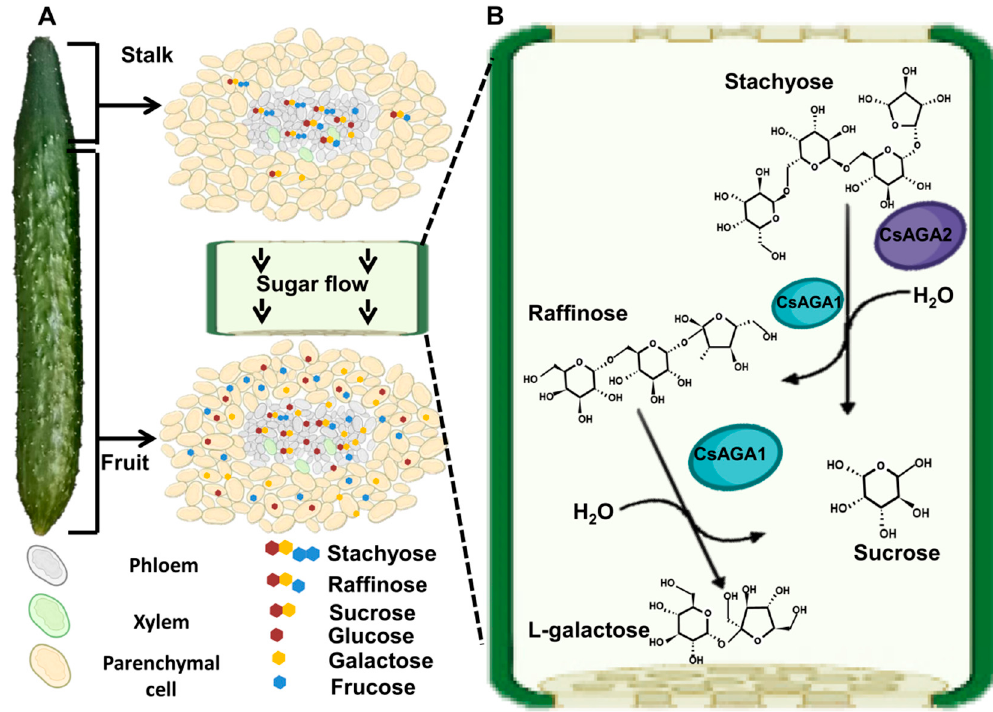
Figure 7. Proposed model of soluble sugar distribution and the process of Raf family oligosaccharides hydrolysis by CsAGA1, CsAGA2. ( A ) The soluble sugar distribution in fruit. Sta and Raf contents in phloem sap are gradually decreased from BF to TF. Suc, Glu and Fru contents are gradually increased in phloem sap from BF to TF. RFOs contents are higher in vascular tissues than in non-vascular tissues. ( B ) CsAGA1 hydrolyses Raf and Sta; CsAGA2 mainly controls Sta hydrolysis. Purple circle indicates CsAGA2, and green circle indicates CsAGA1.